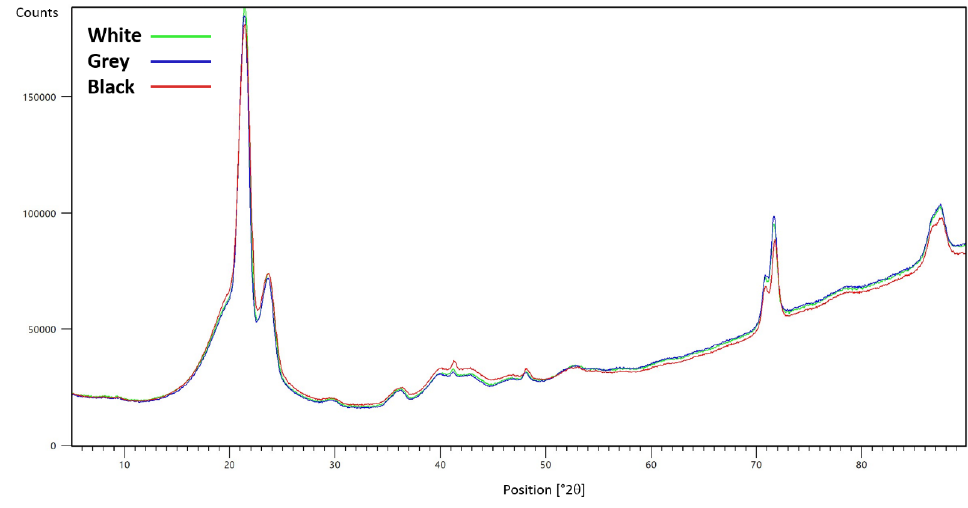
Figure 2. Comparison of XRD curves for white, grey, and black PE foam.